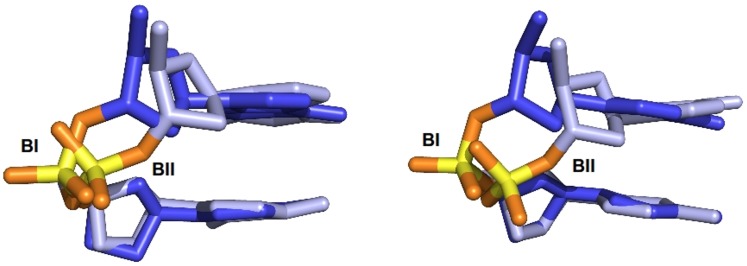
BI and BII conformations in the B-DNA backbone.Illustration of the BI ((ε-ζ) = -90°) and BII ((ε-ζ) = +100°) phosphate linkage conformations with a GpC dinucleotide extracted from MDs carried out with the Parmbsc0εζOLI (left) or CHARMM36 (right) force fields.